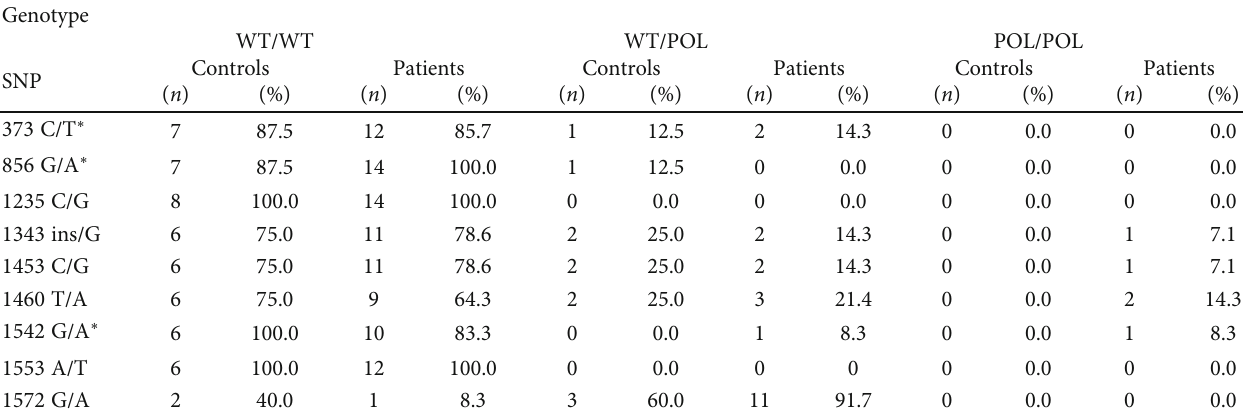
Figure 2: Western blot analysis of TCR ζ and CD3 ε expression. Some patients (P3, P6, P7, and P8) showed reduced TCR ζ expression with an OD ratio below 0.3; others showed values comparable to those obtained in control subjects, C: control subjects, P: patients. Table 2: TCR ζ gene polymorphisms in 44 gastric cancer patients and 33 control